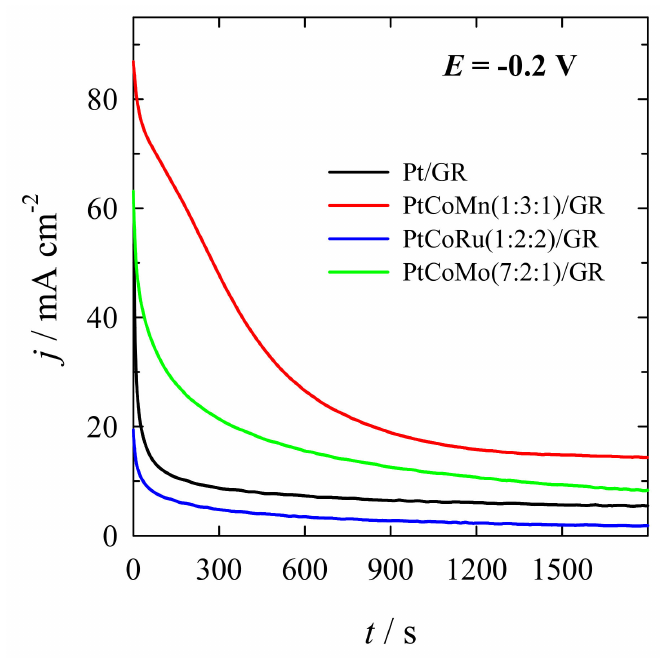
Figure 8. Chronoamperometry data for PtCoMn(1:3:1)/GR, PtCoRu(1:2:2)/GR, PtCoMo(7:2:1)/GR, and Pt/GR in a 1 M CH 3 OH + 1 M NaOH solution, at E = − 0.2 V, t = 1800